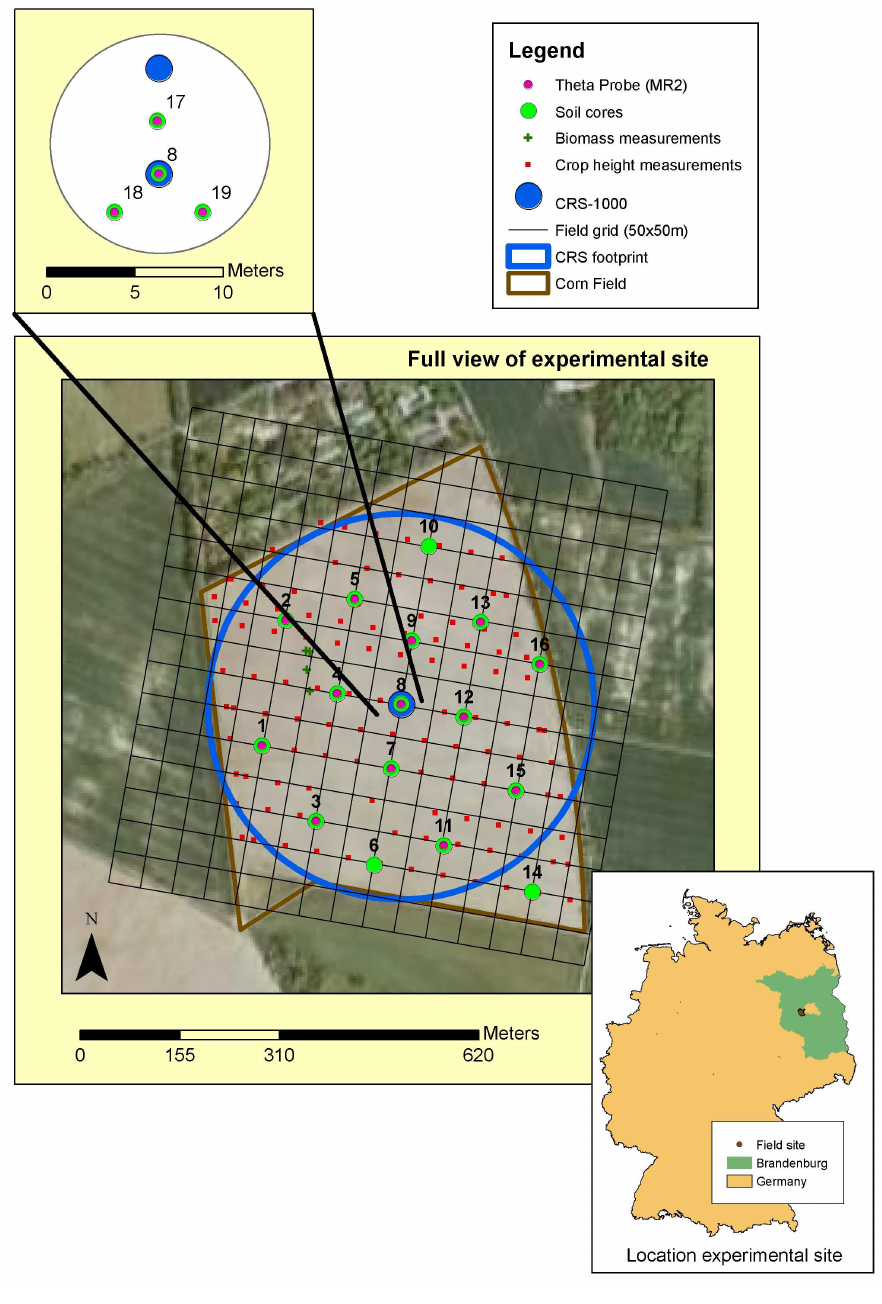
Fig. 1. Location of experimental site and its hydrological Figure 1. Location of experimental site and its hydrological instrumentation. 2